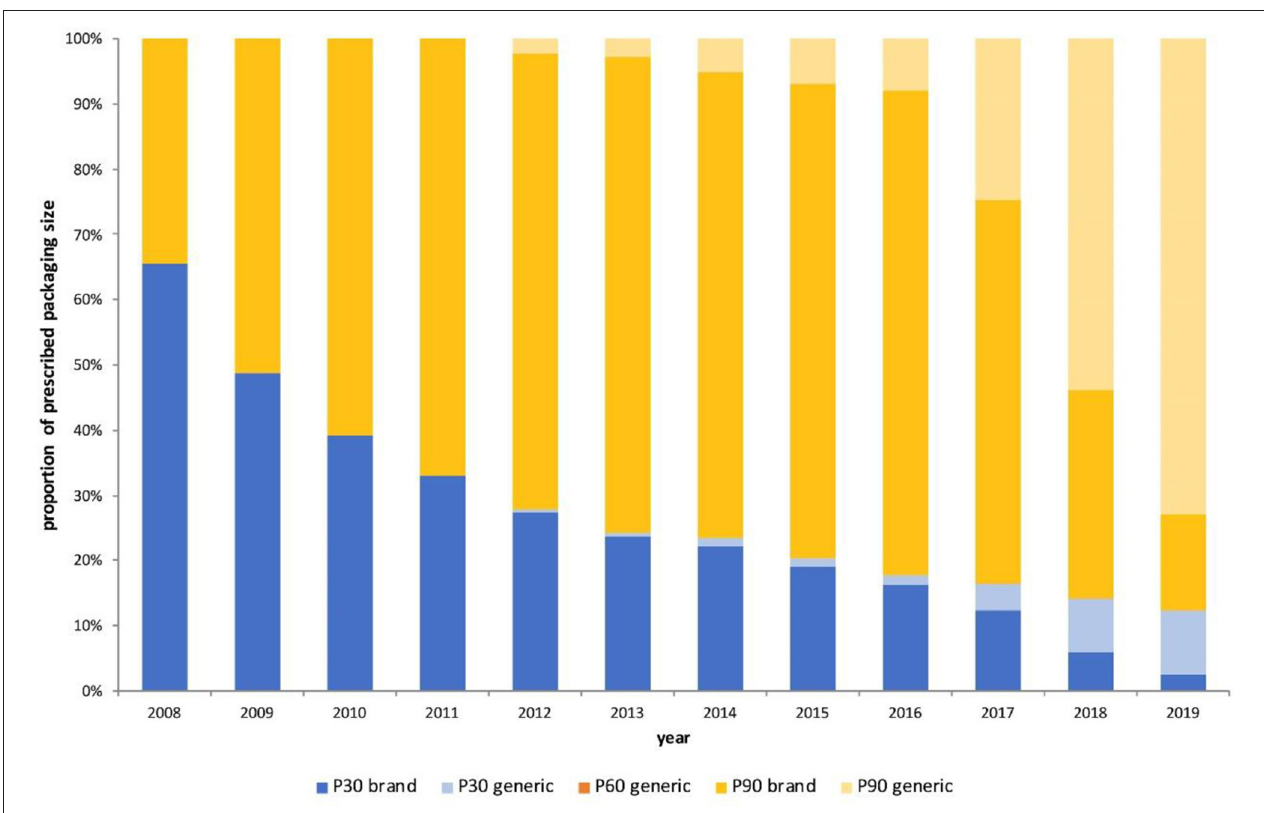
FIGURE 2 | Proportion of prescriptions issued per year by prescription size, 2008–2019. P30–30 pills per prescription; P60–60 pills per prescription; P90–90 pills per